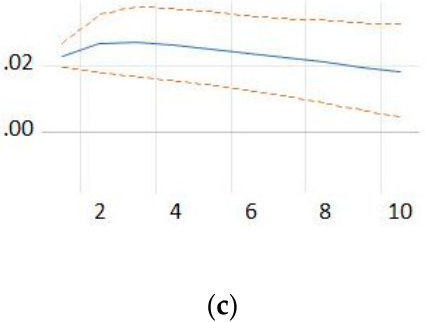
Figure 5. Response of population of active enterprises to a shock from: ( a ) persons employed in the population of births; ( b ) persons employed in the population of deaths; and ( c ) population of active enterprises. Source: the authors’ own computations.